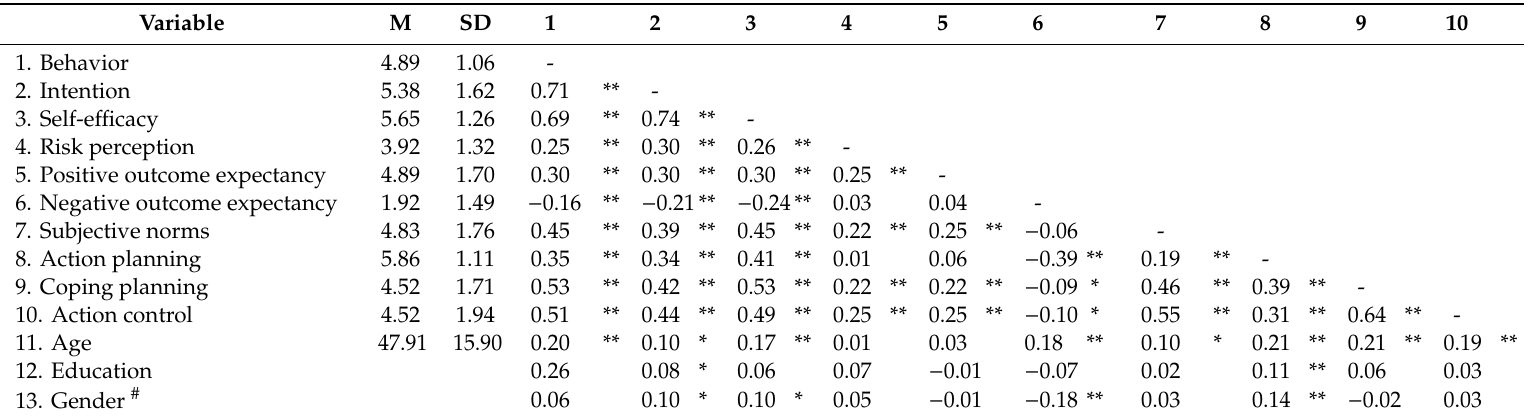
Table 1. Descriptive statistics and correlation matrix of all